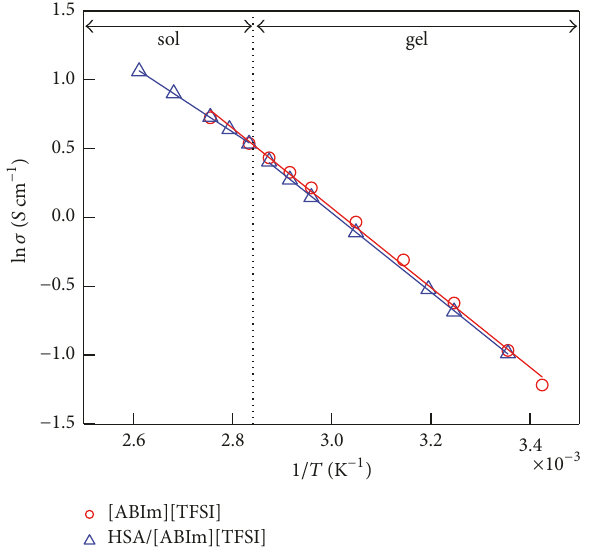
Figure 11: Thetemperaturedependence of the ionicconductivity for a neat [ABIm][TFSI] and 3wt% 12-HSA/[ABIm][TFSI] mixture.